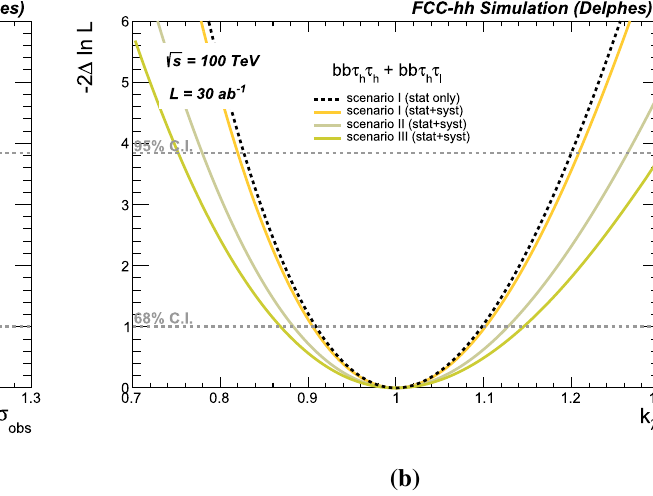
Fig. 10 Expected negative log-likelihood scan as a function the signal strength μ = σ/σ SM ( a ) and trilinear self-coupling mod- ifier κ λ = λ 3 /λ SM ( b ) in the b ¯ b ττ channel (combination of the 3 b ¯ b τ h τ h and b ¯ b τ h τ (cid:10) channels). The various lines correspond